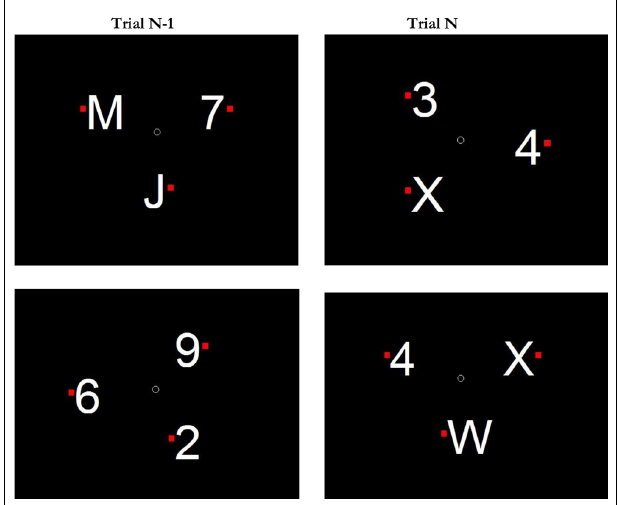
FIGURE 1 | Schematic illustration of stimuli and conditions in Experiments 2 and 3. Top Row: example of a Switch Search condition on trial N.The category-oddball is a letter (X). Participants must respond Left, because the X’s red dot is to the left of the X. Note that on trial N-1, letters were associated with distractor status (the target was a number). Bottom Row: example of aTarget-Category Previewed Condition on trial N.The category oddball is a number (4). On trial N-1, numbers were associated with distractor